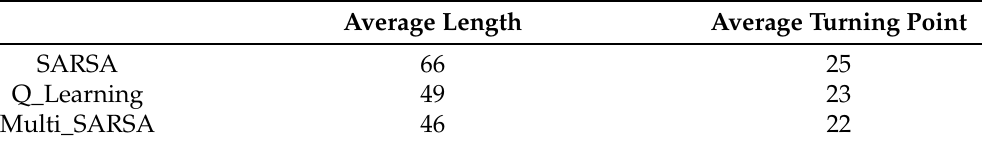
Figure 14. The step diagram of the Multi-SARSA algorithm . Table 3. The experimental results corresponding to Figure